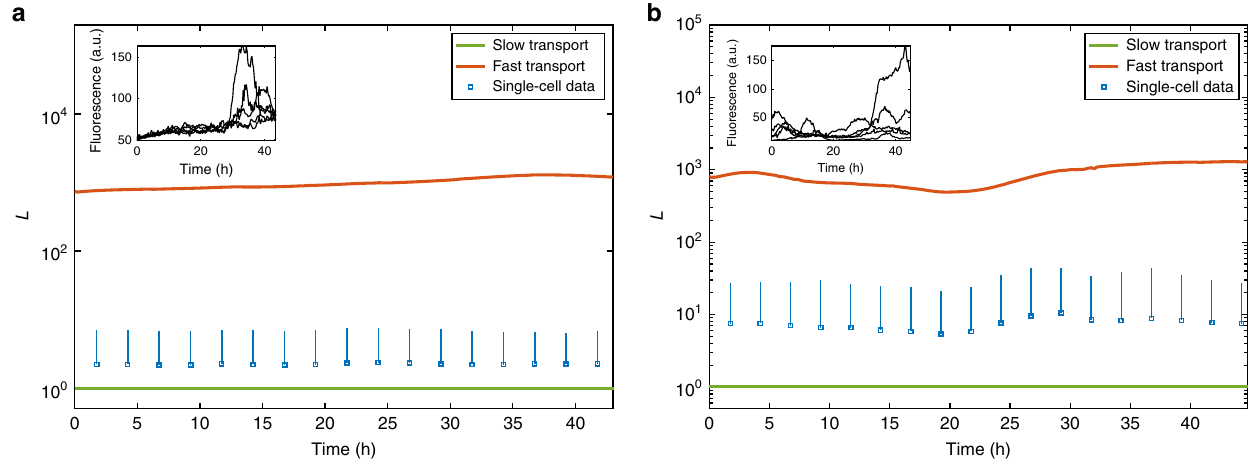
Fig. 5 Comparison of fast (red) and slow (green) transport limits with single-cell data (blue squares: mean; blue bars: 1 standard deviation above mean) for a a tissue of 117 E18.5 rat pituitary cells, b a tissue of 114 P1.5 rat pituitary cells. Insets: typical single-cell trajectories from the raw data. Data are taken from ref.